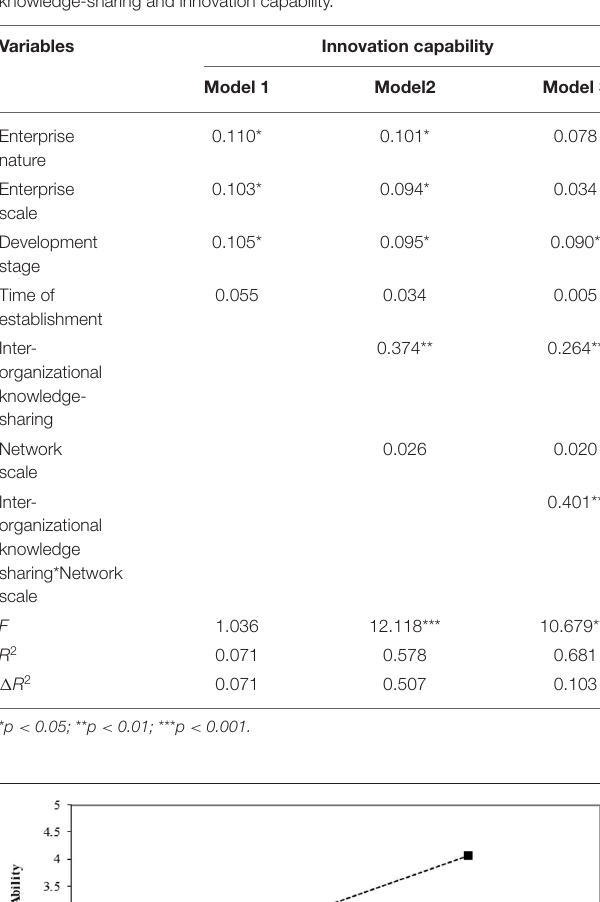
TABLE 10 | Moderator effect test of network scale between inter-organizational knowledge-sharing and innovation capability.